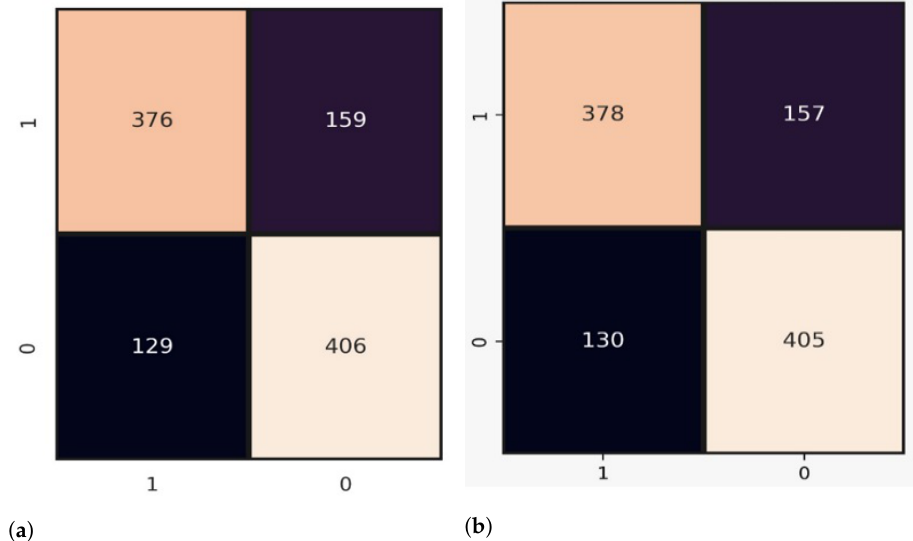
Figure 5. Confusion matrices, ( a ) BoW-based results, and ( b ) TF-IDF-based